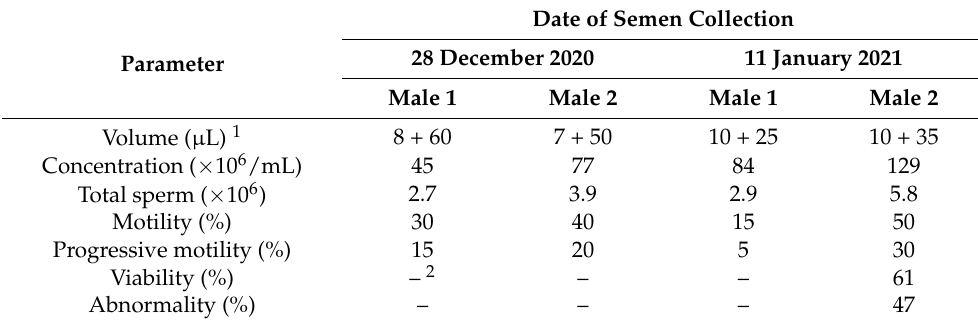
Table 2. Sperm quality collected from the two male Tsushima leopard cats.